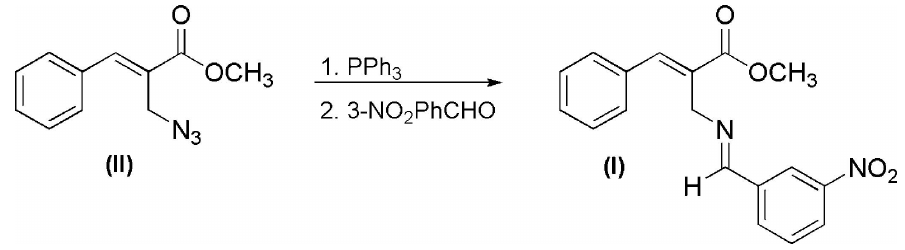
Figure 2 Packing diagram of the title compound showing the formation of chains parallel to the [0 1 1] direction. Hydrogen bonds are shown as dashed lines.